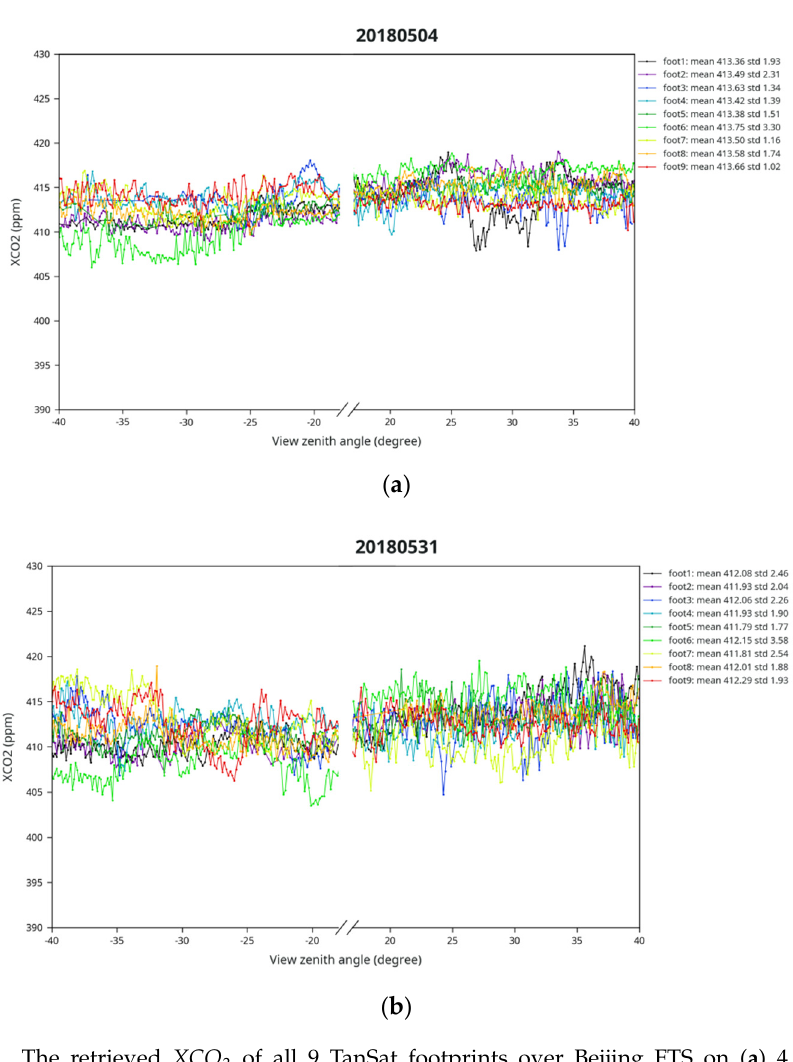
Figure 10. The retrieved XCO2 of all 9 TanSat footprints over Beijing FTS on ( a ) 4 May and ( b ) 31 May 2018.